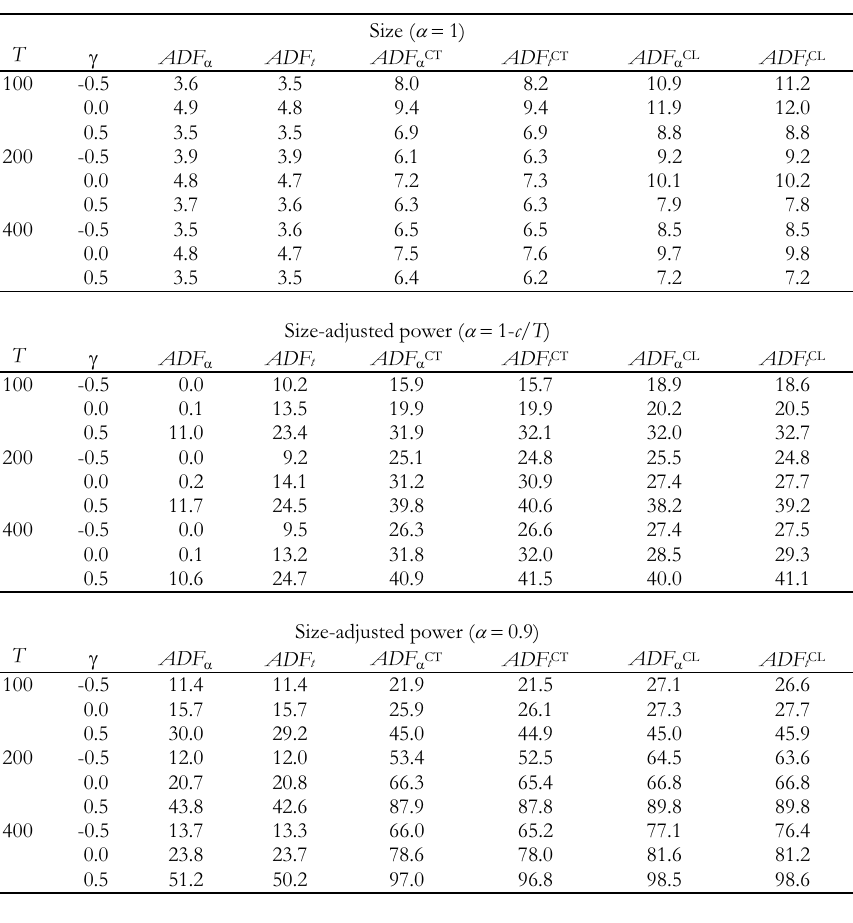
Comparison between standard Dickey-Fuller tests and the new unit root tests based on traditional level shift estimation. Model S (random level shifts, four on average, at least r